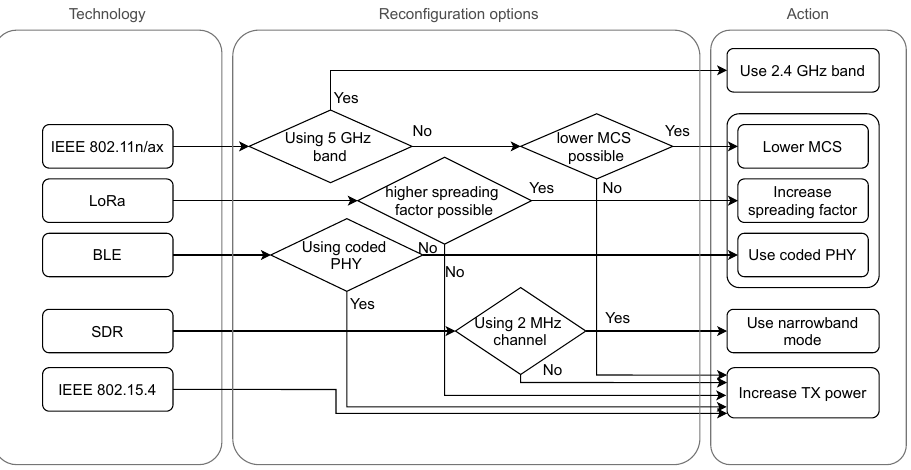
Figure 5. Reconfiguration algorithm: reconfiguring PHY parameters for different wireless